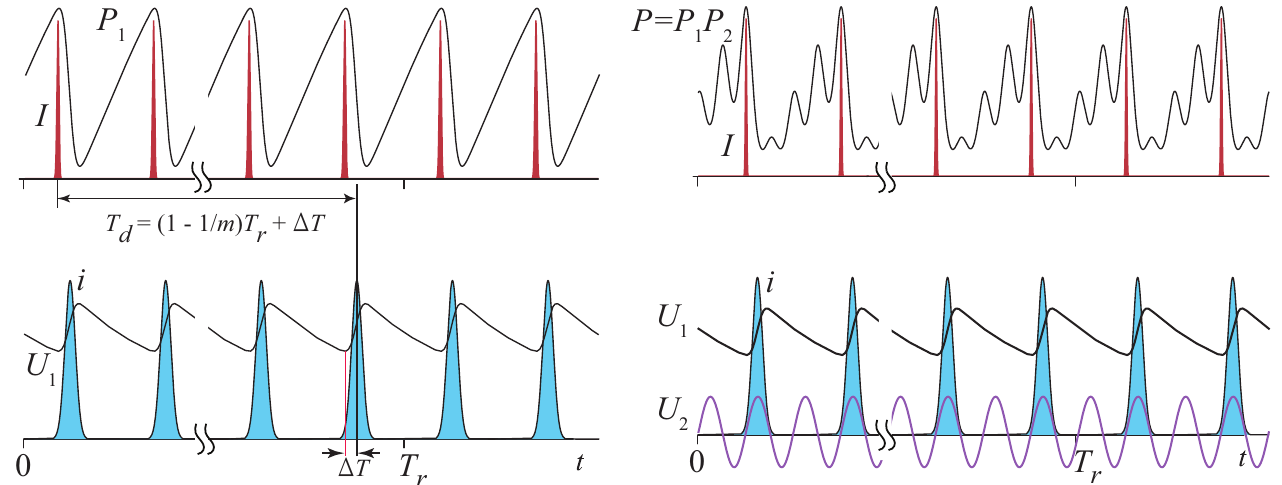
Figure 3. SSHML operational mode with m pulses in the cavity: single NFB action ( left ) and combined action of NFB and RF modulation. Temporal profiles of laser intensity I ( t ) , photocurrent i ( t ) , EOM 1 control voltage U 1 ( t ) , EOM 1 transmission P 1 ( t ) , EOM 2 control voltage U 2 ( t ) , total transmission P ( t ) . T d is the feedback delay, T r is the cavity round-trip